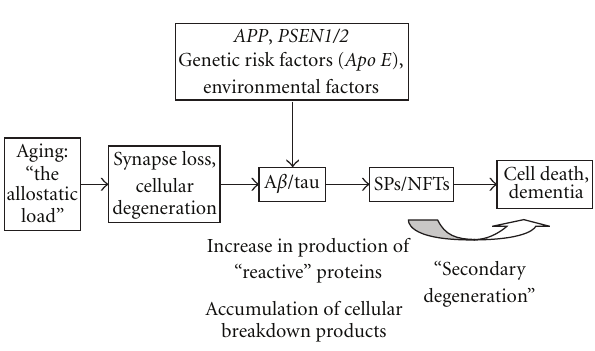
Figure 3: A modification of the Amyloid Cascade Hypothesis (ACH). A β : β -amyloid, APOE: apolipoprotein E, APP: amyloid precursor protein, PSEN1/2 : presenilin genes 1 and 2 , NFTs: neu- rofibrillary tangles, and SPs: senile